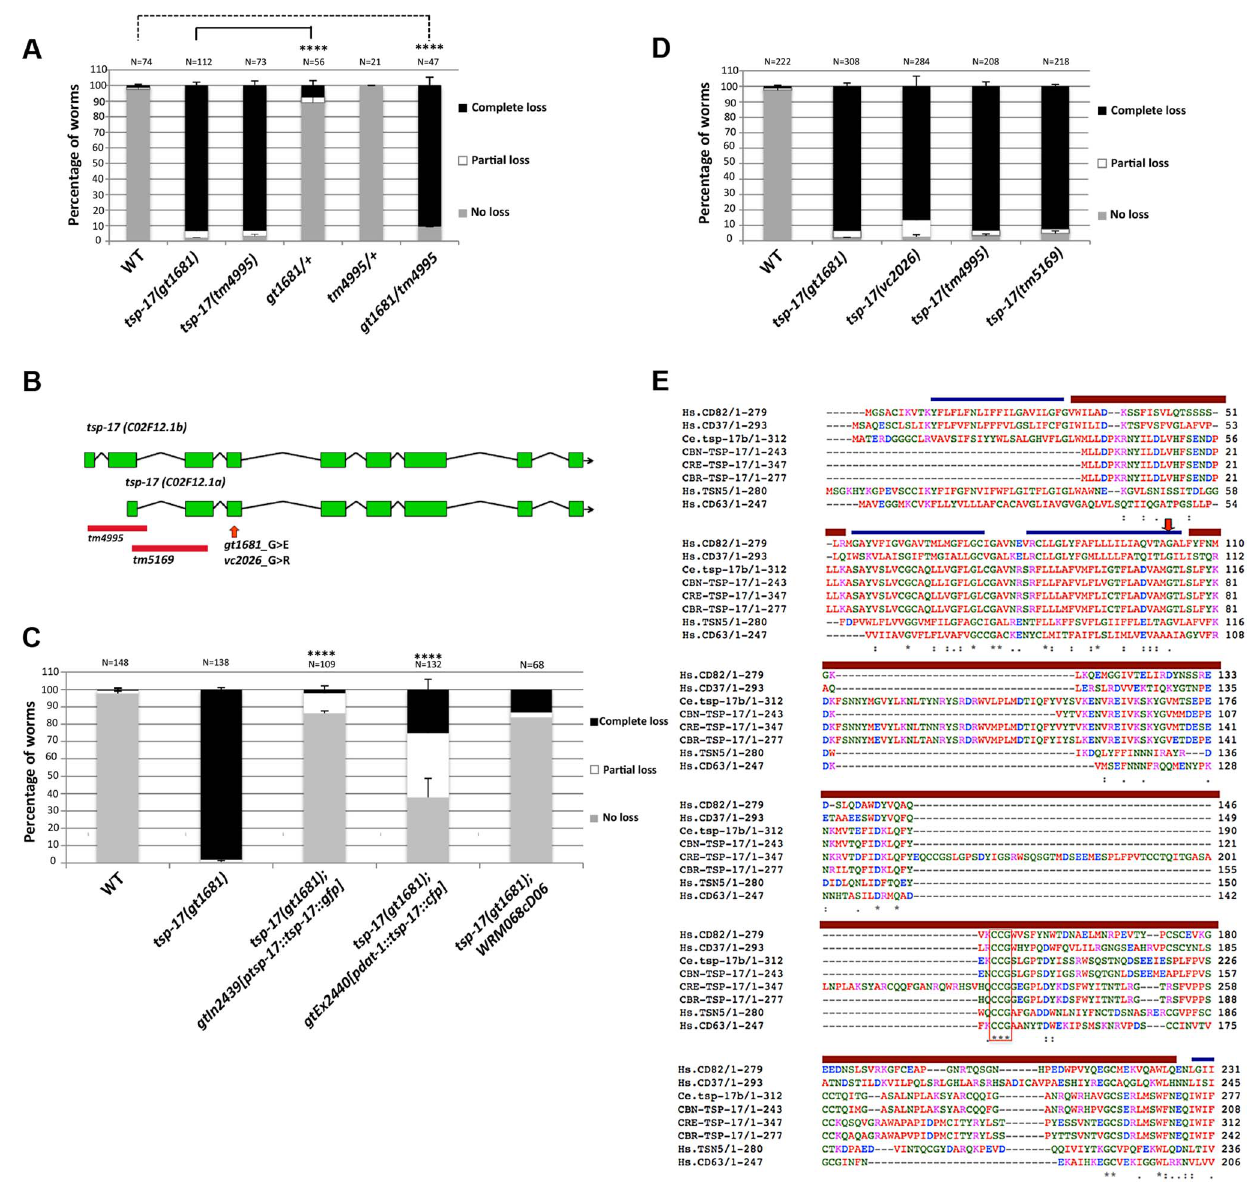
Figure 2. The TSP-17 tetraspanin family member protects dopaminergic neurons from 6-OHDA. A . Extent of neurodegeneration in heterozygous and trans-heterozygous worms 72 h post 6-OHDA intoxication. B . Schematic gene model of the two isoforms of tsp-17 . Alleles used in this study are indicated. C . Complementation of tsp-17 expressed under its own promoter (3 rd column strain TG2439) and under the dat-1 promoter (4 th column, strain TG2440). Data presented is from scoring the extent of neurodegeneration 72 h post 6-OHDA intoxication. Asterisks represent statistical significance of differences between tsp-17 and the rescuing lines (****p , 0.0001). D . 6-OHDA hypersensitivity conferred by various tsp-17 alleles. E . Alignment of nematode TSP-17 to the most closely related human tetraspanins. Blue bars indicate transmembrane domains and brown bars designate extracellular loops (EC1 and EC2). The arrow indicates amino acid G109, which is mutated in the C. elegans gt1681 and vc2026 mutants. The red box indicates the CCG motif in the EC2, which is highly conserved throughout the tetraspanin protein family. Hs, Homo sapiens ;